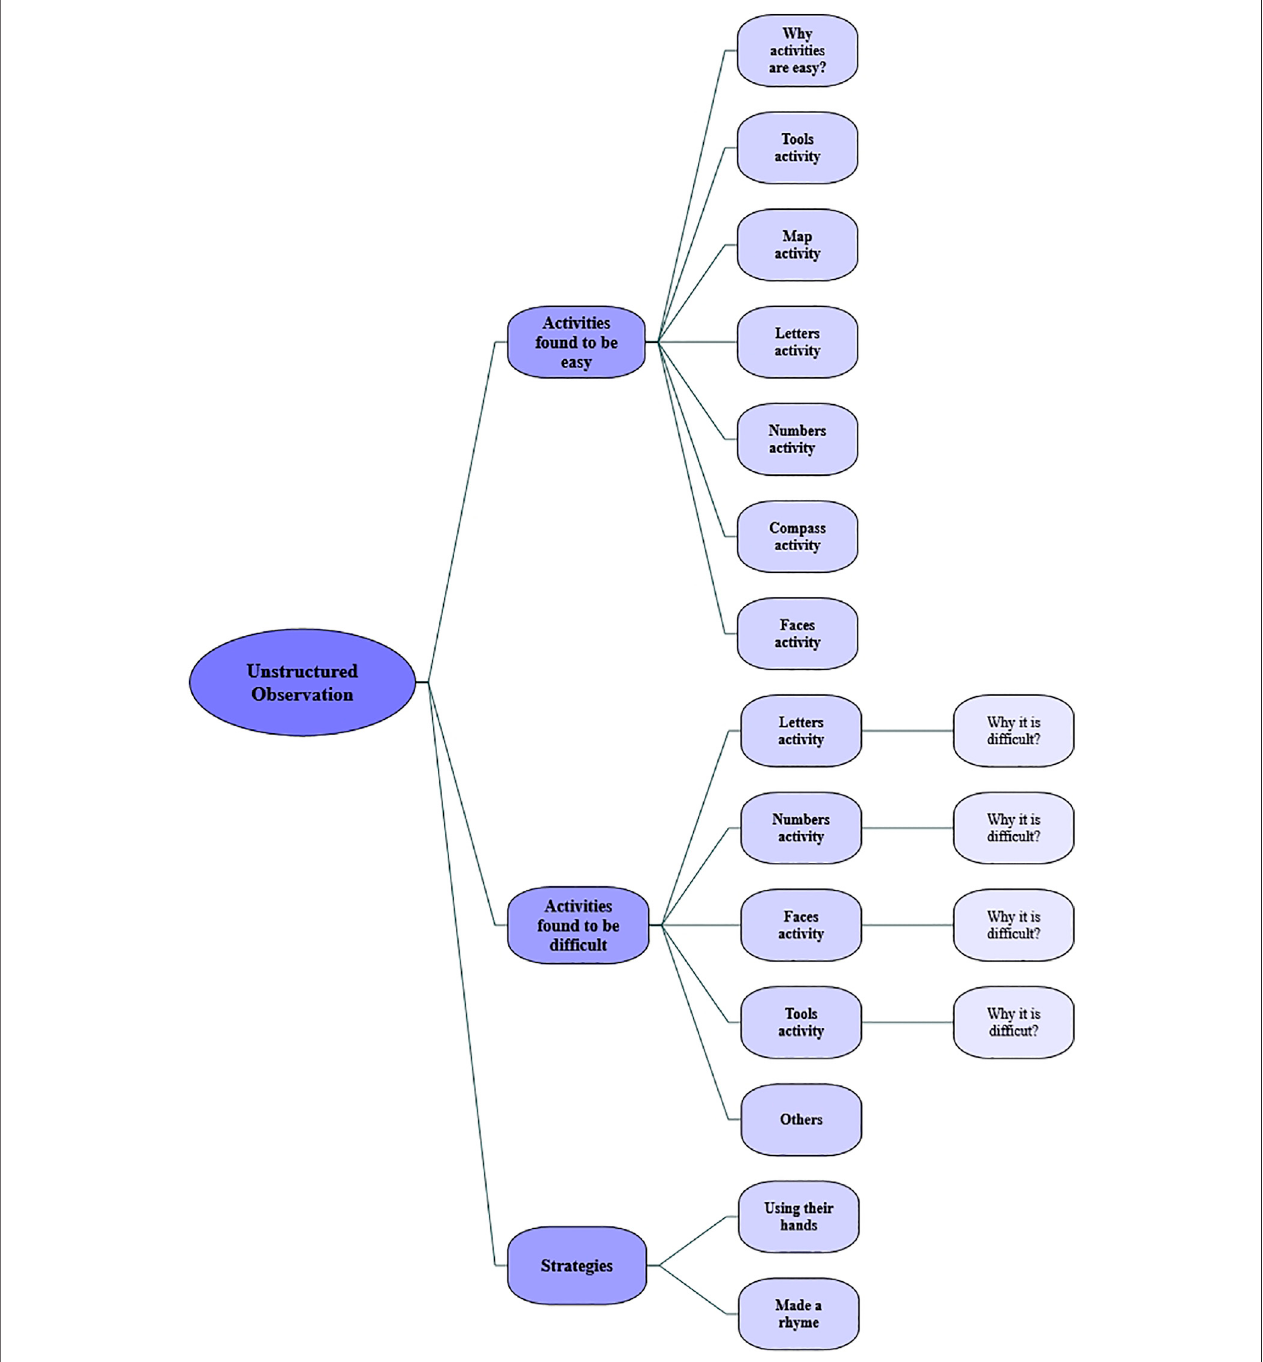
FIGURE 2 | Overarching thematic map for the unstructured observation shows the three global unstructured observation ’ s themes and its individual thematic networks.